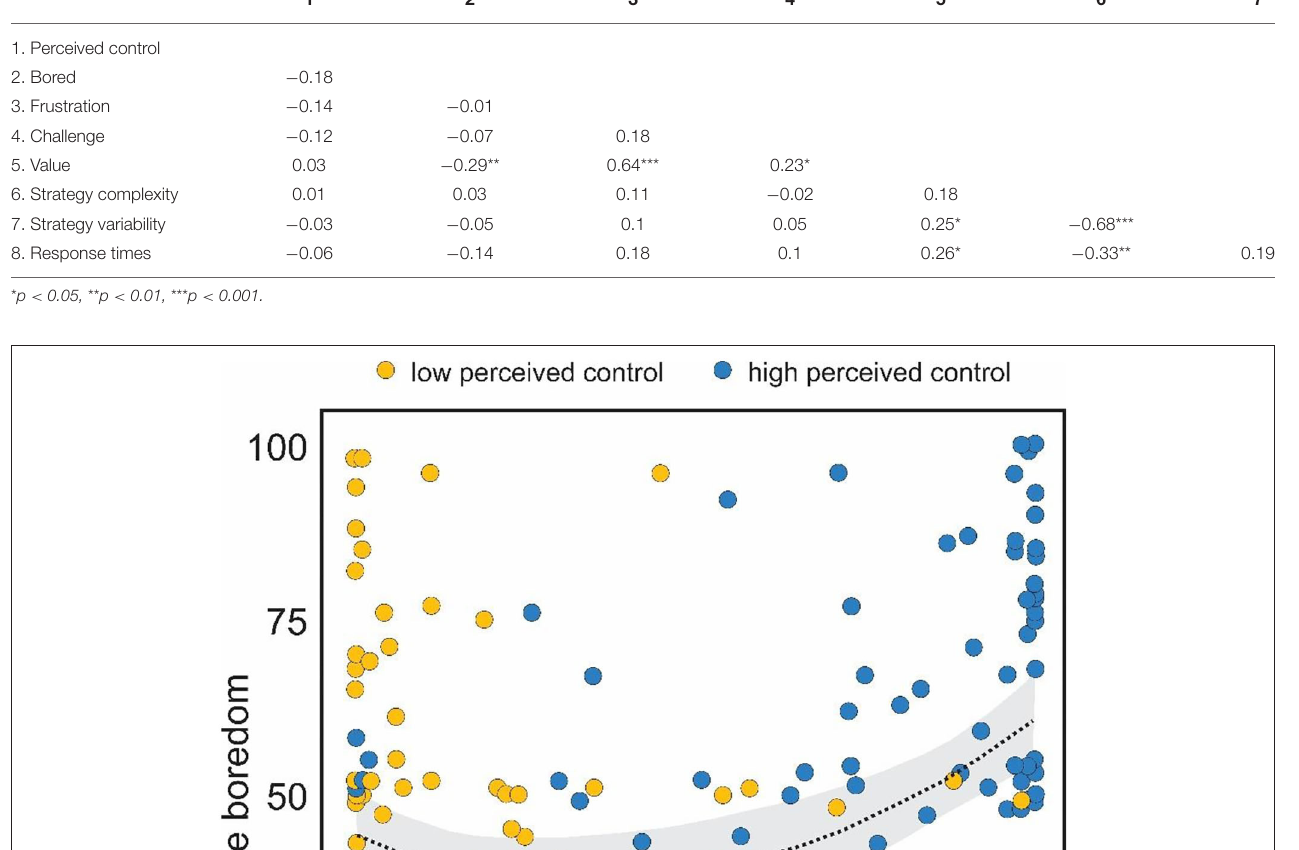
variance in boredom as challenge, and serves as a better predictor of boredom. To test whether perceived control affects engagement, we tested differences in behavioral measures across the two